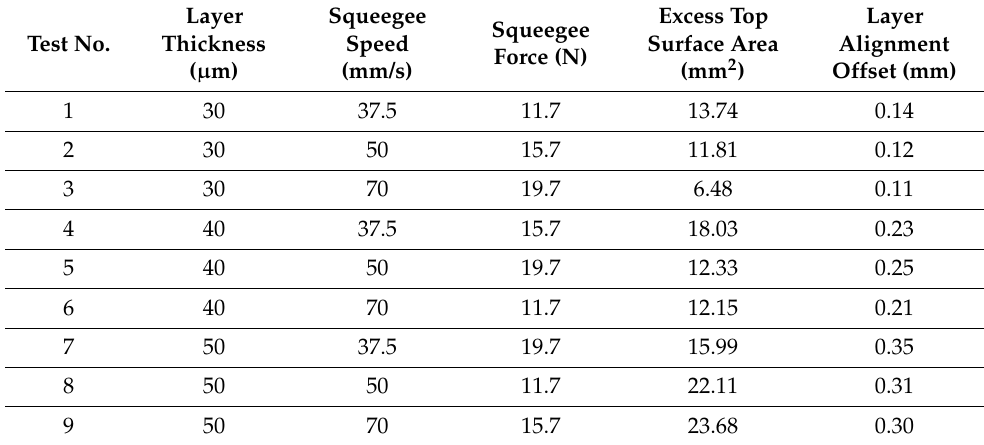
Table 2. Results of the L9 OA tests and measurements for the 5 mm by 5 mm cube. Test No.